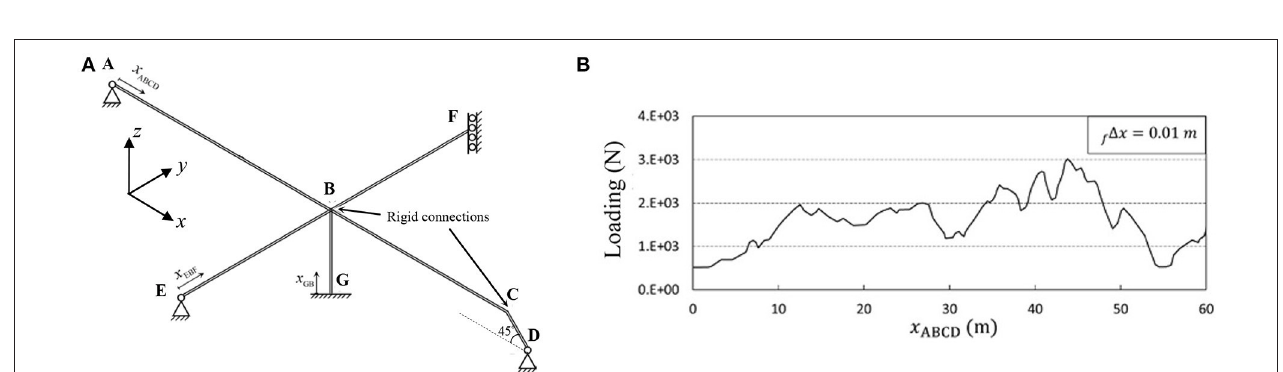
FIGURE 10 | Structural system in the last example (A) structural model and (B) loading.